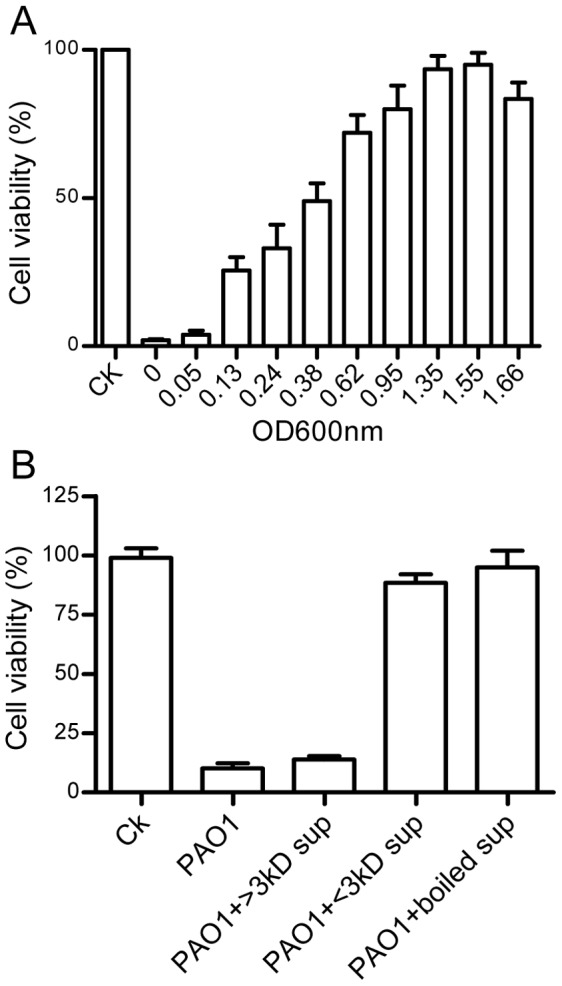

P. aeruginosa produces a small chemical inhibitor(s) in a cell density-dependent manner.(A) Virulence-inhibitory activity of strain PAO1 culture supernatants. The bacterial supernatants of different growth stages (OD600) were used as co-culture mediums when A549 was infected against PAO1 (MOI 50). Control (CK) is the normal A549 culture without bacterial infection. (B) The physical properties of the putative virulence inhibitor(s). PAO1 supernatants (sup) at OD600 = 1.6 were prepared as larger (>) and smaller (<) than 3 kD fractions respectively by using a Centricon-3 ultrafiltration device. A portion of PAO1 sup was boiled at 100°C for 10 min before bioassay. These sup preparations were used to prepare PAO1 inoculum and infect A549 cell lines as described above. The experiment was repeated three times and the data shown are the means of 3 replicates with standard deviation.